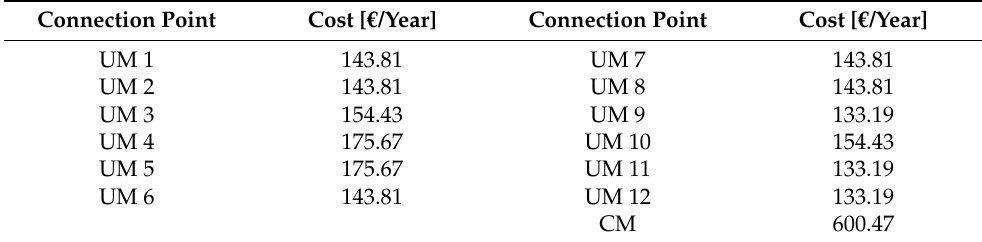
Table 4. JARSC group members fixed electricity